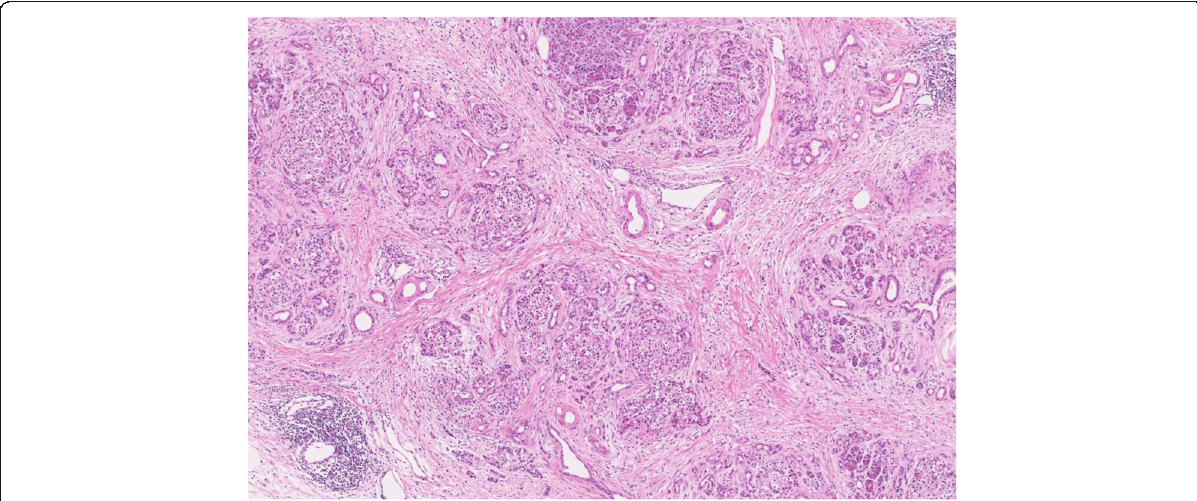
Fig. 5 Microscopic findings of pancreatic parenchyma on the section of the tail side of the tumor. Atrophy of acinar cells and fibrosis were localized, and the acinar cells were relatively retained (hematoxylin and eosin; original magnification, ×